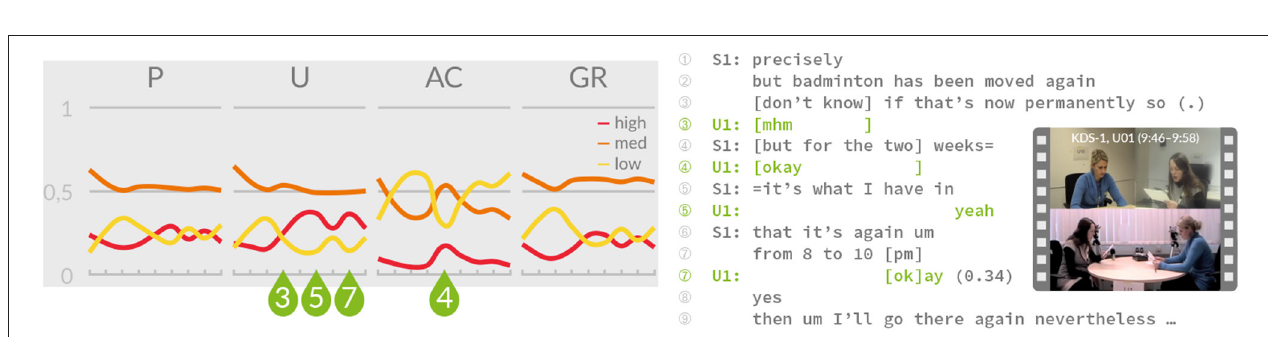
FIGURE 3 | In the attributed listener state model of feedback understanding, the listener’s likelihood of perception (P), understanding (U), acceptance (AC), and grounding-potential (GR) is inferred incrementally while the speaker is presenting information (adapted from Buschmeier and Kopp, 2014).